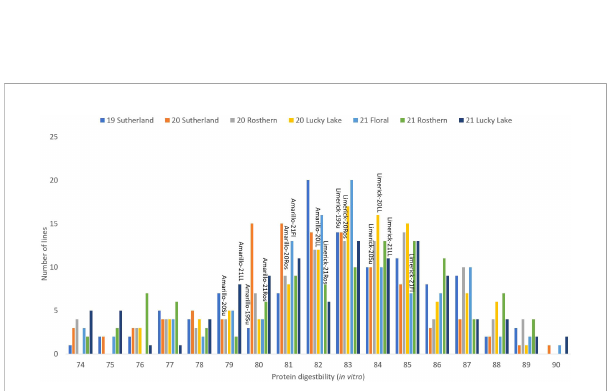
FIGURE 6 Frequency distribution of protein digestibility ( in vitro ) of PR-25 across seven station-years based on the average of biological replicates for each line in each station-year (two biological replicates in 2019 Sutherland and three biological replicates for the rest of the station-years), and the averaged protein digestibility ( in vitro ) for the parents of PR-25 in each